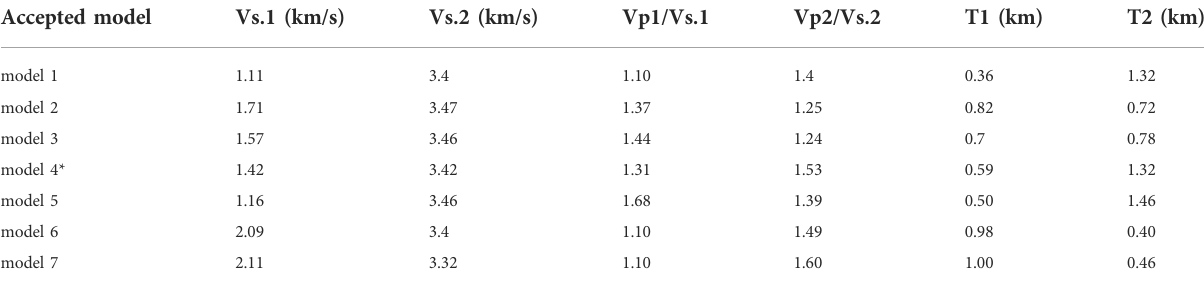
TABLE 2 The models fi tting the SP15 seismic